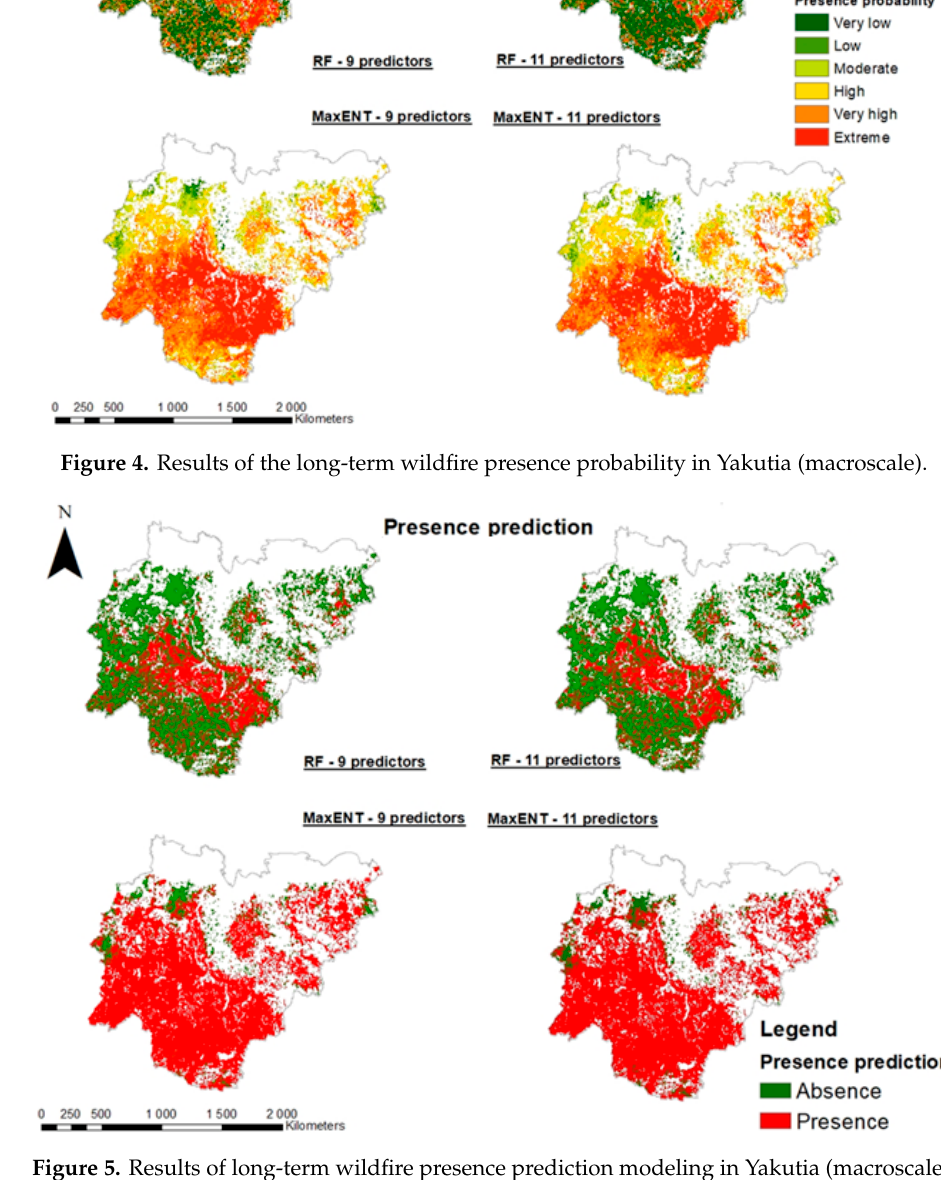
Figure 5. Results of long-term wildfire presence prediction modeling in Yakutia (macroscale).